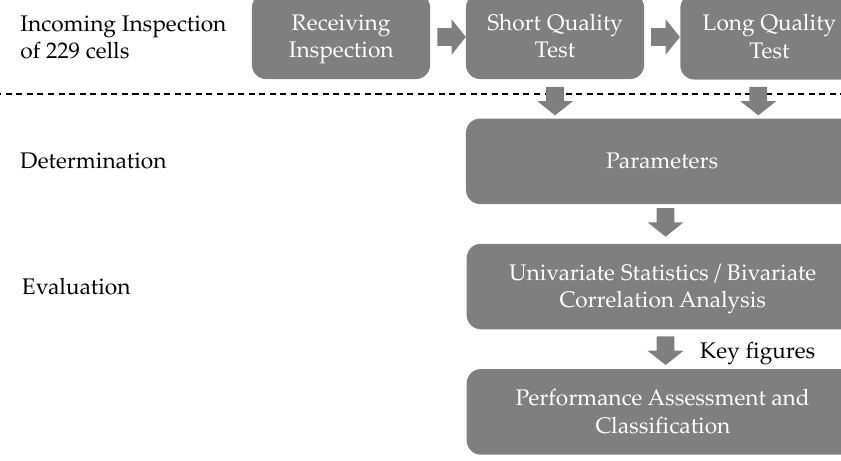
Figure 2. Procedure for evaluation of the parameters.